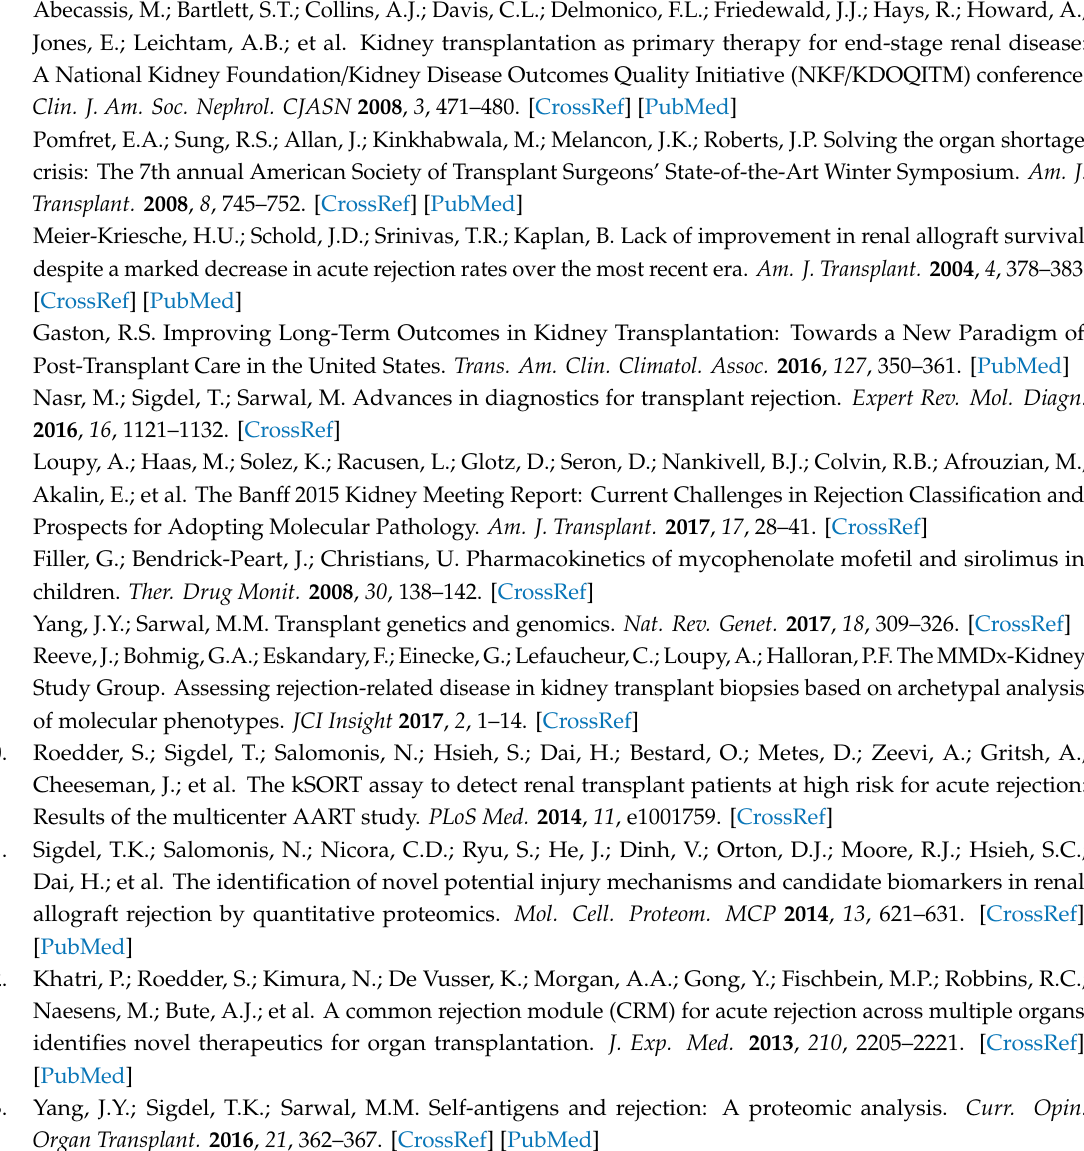
Table S1: Metabolite selection by VSURF to discriminate BKVN from all other phenotypes, Table S2: Metabolite selection by VSURF to discriminate BKVN from STA, Table S3: Use of all 266 metabolites in VSURF to discriminate BKVN from STA, Figure S1: Volcano plot displaying fold change and significance of metabolites in the urine of acute rejection patients compared to the patients with stable